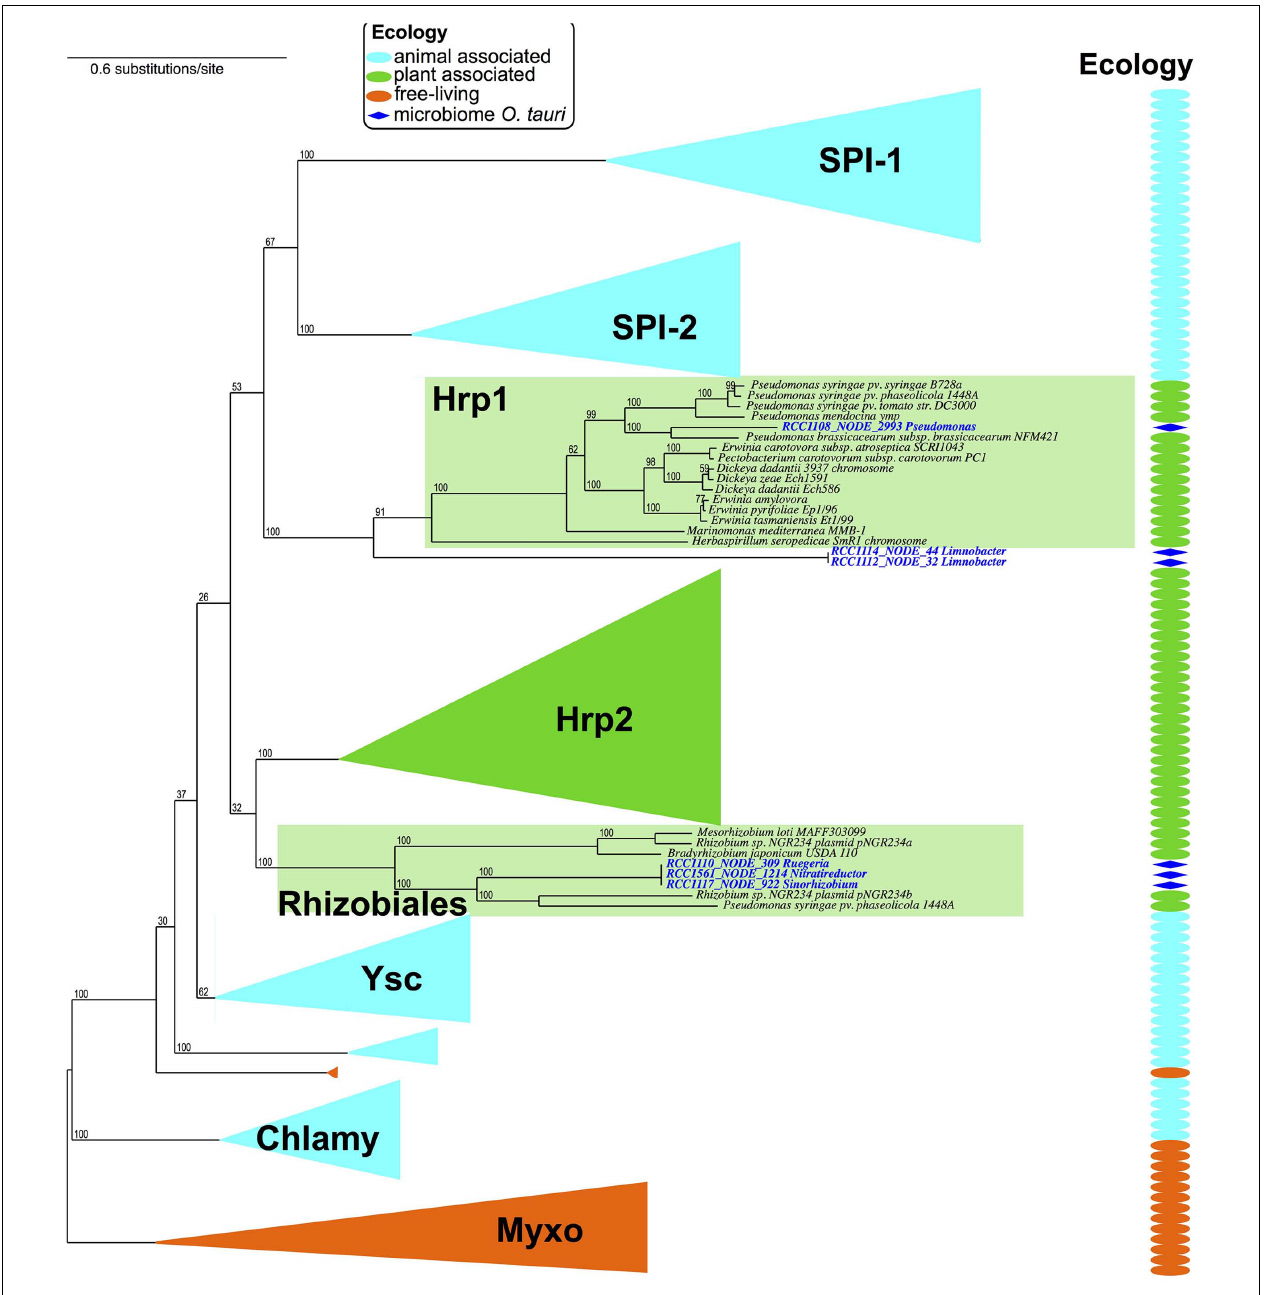
FIGURE 4 |The phylogeny of T3SS reflects host-cell type. TheT3SS detected in O. tauri microbiomes were integrated in a reference phylogeny of theT3SS (Abby and Rocha, 2012).T3SS phylogeny shows a diversification of T3SS into host-cell adapted sub-types: animal associated, and plant